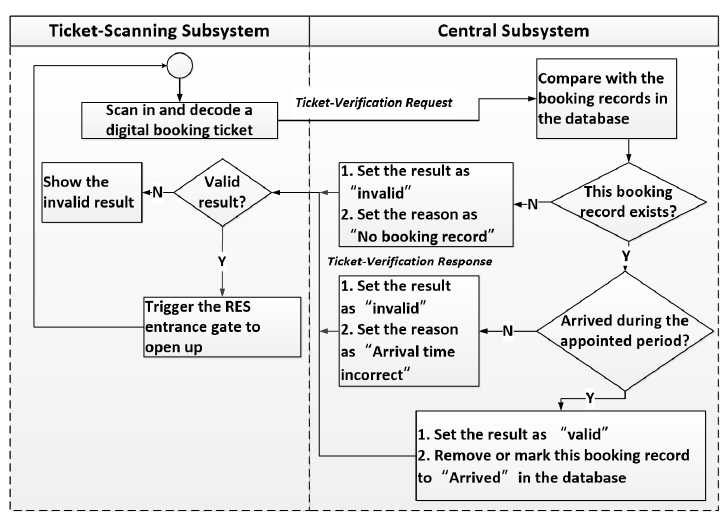
Figure 3. Message flow chart of attraction reservation.